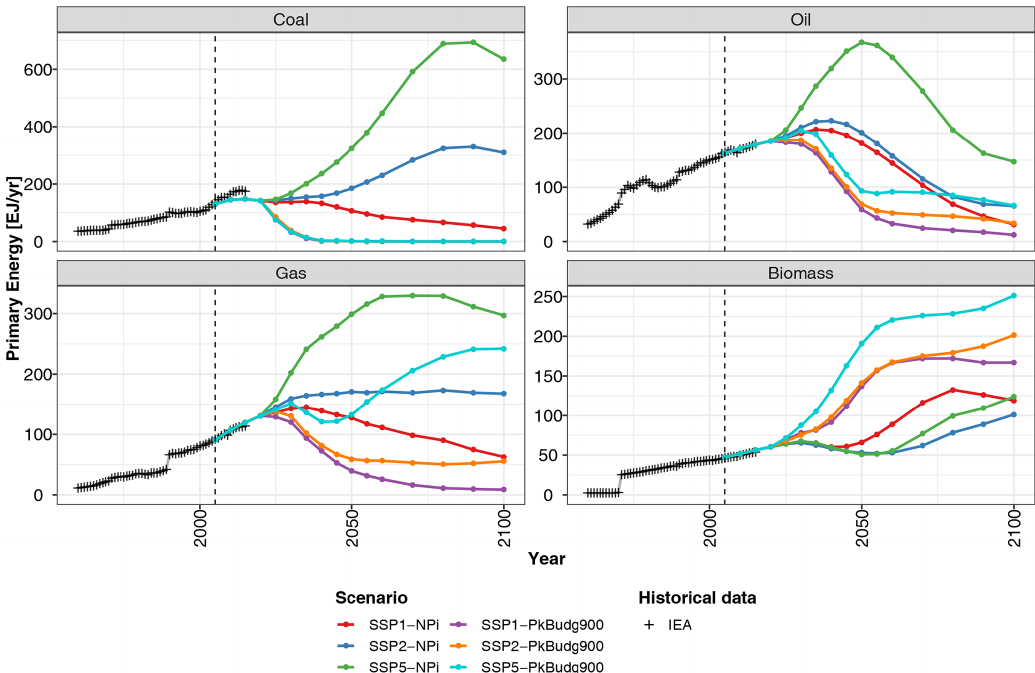
Figure A1. Global primary energy consumption of different energy carriers for NPi and pkBudg900 (1.5 ◦ C) scenarios of SSP1, SSP2 and SSP5 compared to historical data from IEA.